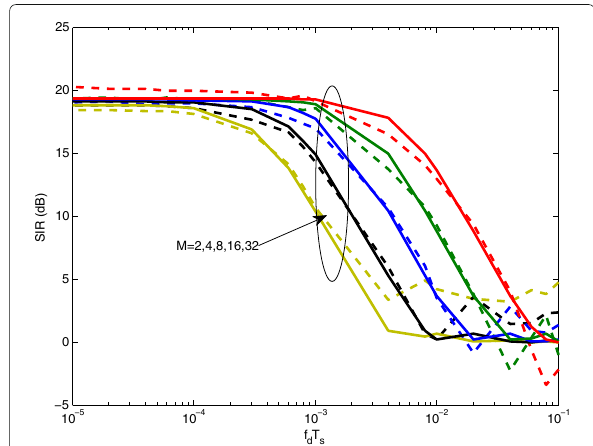
Fig. 5 The simulated equalized SIR and theoretical equalized SIR with M = 2,4,8,16,32, N s = 512, and SNR = 25 dB. The dashed line denotes the simulated results, and the solid line denotes the theoretical results